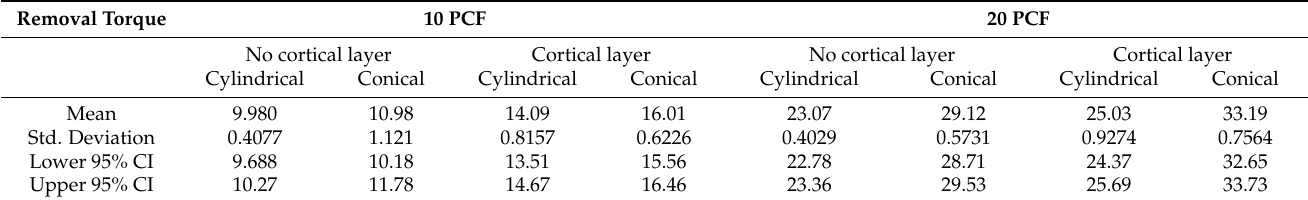
Table 2. Summary of the removal torque (RT) values of the tested cylindrical and conical implants.